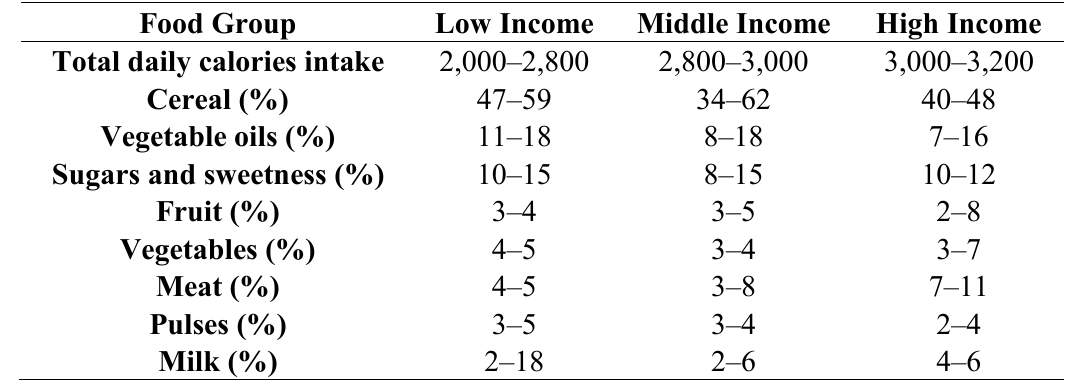
Table 5. Share of some food groups in total available per capita dietary energy consumption (percent) in the Arab countries, according to their income (2003–2005), based on food balance